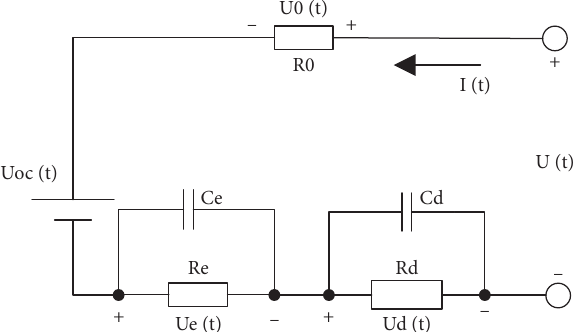
Figure 6: Second-order RC equivalent circuit